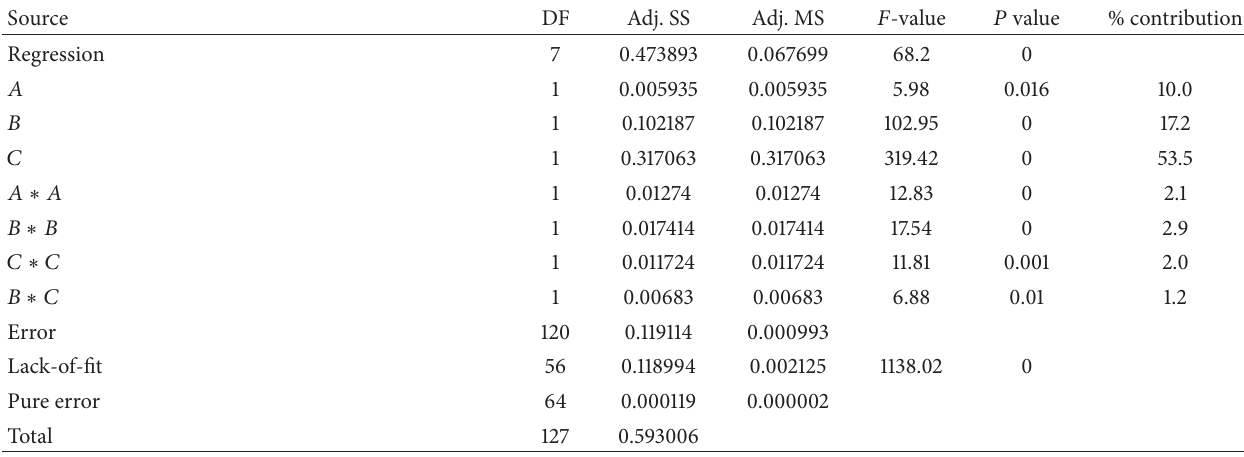
Table 4: ANOVA for 𝑅 𝑎 after removing insignificant